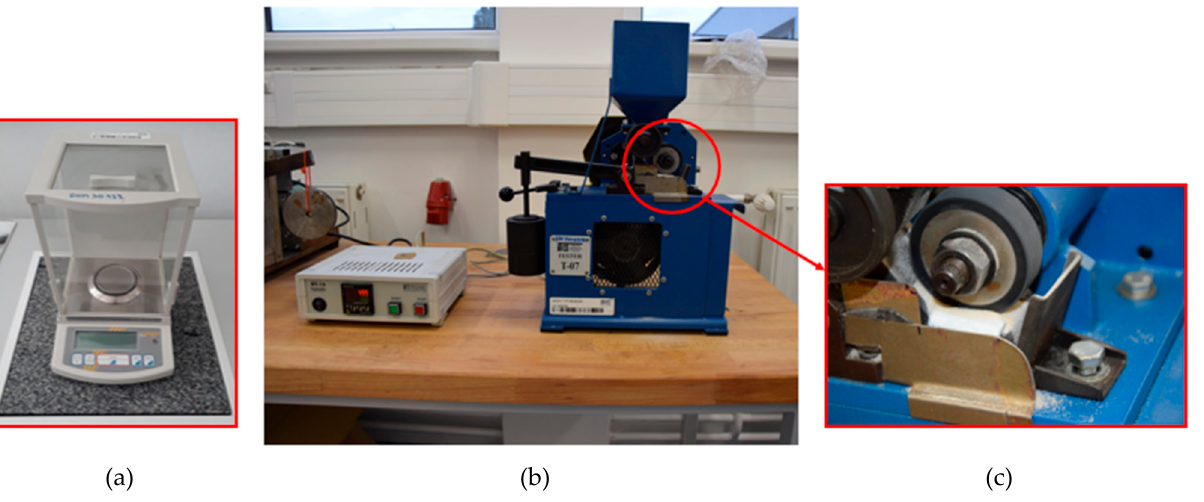
Figure 8. Abrasion resistance and weight measuring equipment (scales); ( a )—scales; (b)—abrasion